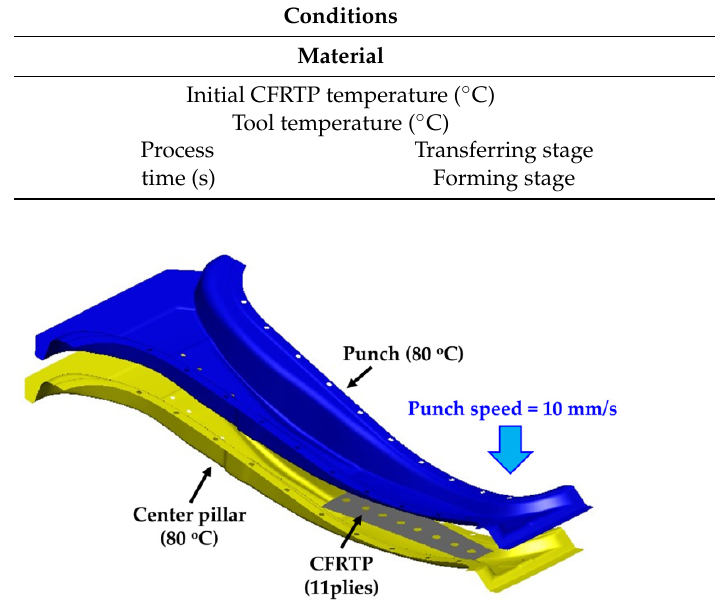
Figure 6. FE model of forming process of CFRTP part.